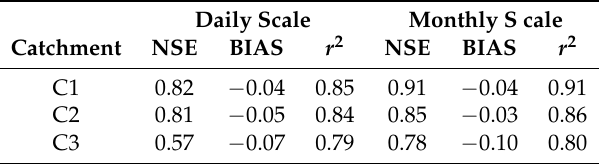
Table 2. Goodness of fit of simulated runoff at daily and monthly scale.